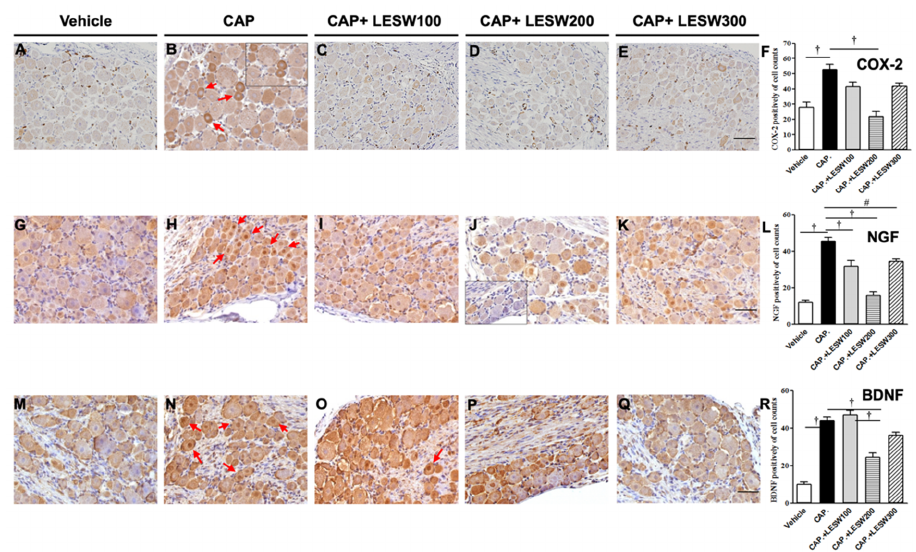
Figure 1. Immunohistochemistry staining of L6 DRG on day three post capsaicin injection with or without Li-ESWT. Intraprostatic capsaicin (CAP) injection-induced increase in COX-2, NGF, and BDNF expression in the L6 DRG ( B , H , N , red arrow), which effects were decreased in the 200 and 300 shock wave treatment groups ( D , E ). All three groups of Li-ESWT significantly decreased NGF immunoreactivity ( L ), while only 200 shocks of Li-ESWT significantly decreased COX-2 and BDNF-positive neurons ( F , R ). ( A – E ): COX-2 stain; ( G – K ): NGF stain; ( M – Q ): BDNF stain; ( F , L , R ): positive neurons per visual field. Magnification ×400; inlet, magnification ×400; scale bars indicate 50 μm. Statistically significant difference between groups ( n = 10 per group; # p < 0.01; † p < 0.001) ( F , L , R ). 2.2. Immunostaining—Li-ESWT Decreased Upregulation of Trk-A and TRPV1 Immunoreactivity in L6 DRG Induced by Intraprostatic Capsaicin Injection The Trk-A- and TRPV1-positive neurons in the L6 DRG increased on day 3 after intraprostatic capsaicin injection. Constitutively expressed Trk-A colocalizes with TRPV1, and the increased immunoreactivity was suppressed by a 200-shock wave treatment (Figure 2). Double immunostaining showed that Trk-A immunoreactivity was co- localized with BDNF. BDNF-positive neurons associated with the expression of Trk-A immunoreactivity were increased in the prostatitis groups (Figure 3B,G,L), whose effects were attenuated by 200 and 300 shocks of Li-ESWT (Figure 3N,O).